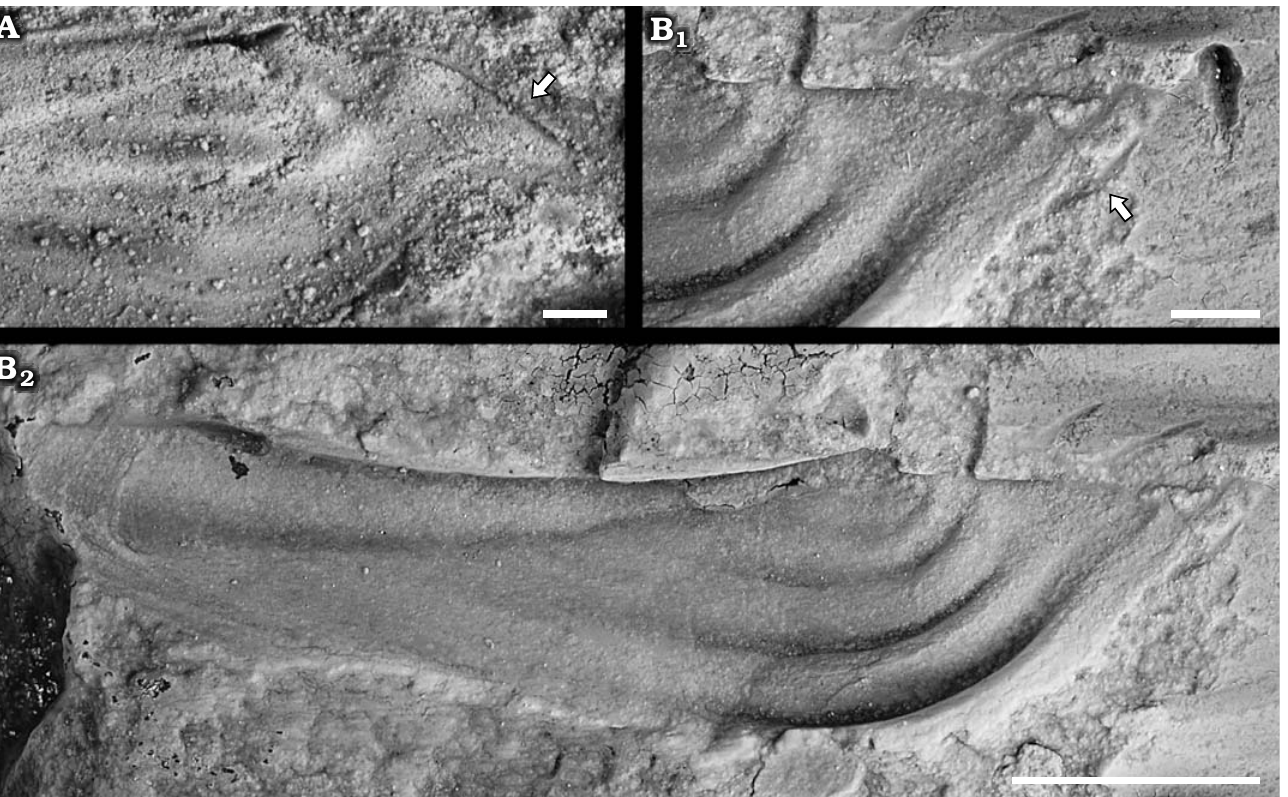
Fig. 5. Pachydomid bivalve Leinzia similis (Holdhaus, 1918) (sensu stricto), Rio do Rasto Formation, Guadalupian (Permian), Paraná Basin, Brazil. A . DGP/7-88, right valve, detail of the cardinal margin showing a strongly deformed rostrum (arrowed). B . DGP/7-85, external mold, left valve; B 1 , the comarginal rugae on the anterior rostrum (arrow); B 2, general view of the shell with well-preserved anterior rostrum. Scale bars A, B 1 , 1 mm; B 2 , 5 mm.